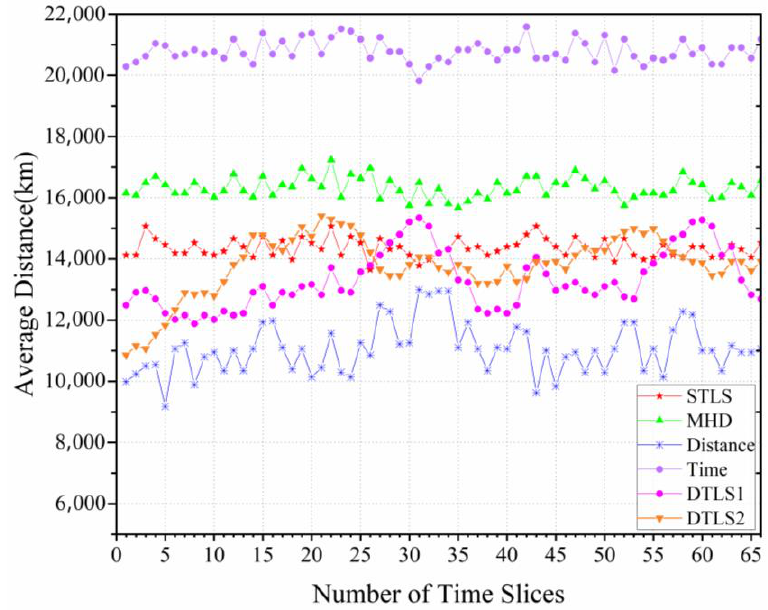
Figure 6. Comparison of average packet call distances over the cycle of the six topologies The dynamic topology generated by the Time strategy has the longest average call distance. Comparing the static topology generated by STLS and MHD policies, STLS has a shorter average call distance while the MHD strategy generates a longer distance for the topology. When comparing the dynamic topology with the static topology, the DTLS1 strategy reduces the average call distance by 7.26%, and the DTLS2 strategy reduces the average call distance by 3.81% compared to the STLS strategy if STLS is used as a bench- mark. In the STLS strategy, the distance variation is minor, indicating a more stable link, while all three dynamic policies require reconnection of the link with the switch of the time slice, so the distance variation is more significant. Comparing several dynamic topologies, the DTLS1 strategy proposed in this paper is superior to all other strategies except for the Distance strategy. When using the Time strategy as a baseline, DTLS1 reduces the distance by 35.97% compared to it, while DTLS2 reduces the distance by 33.59%; when using the Distance strategy as a baseline, DTLS1 increases the distance by 20.28% compared to it, while DTLS2 increases distance by 24.75%. The simulation results demonstrate that for the 2 combinations of DTLS1 and DTLS2, it is evident that the DTLS1 strategy reduces the average distance by 3.58% compared to the DTLS2 strategy. As the average call distance of data transmission packets decreases, network performance improves. Therefore, the DTLS1 strategy performs better. 5.2. Number of Hops for Packet Forwarding Figure 7 shows the number of packet hops forwarded between 10,000 pairs of ran- domly selected ground stations in 6 topologies at the beginning of each time slice.